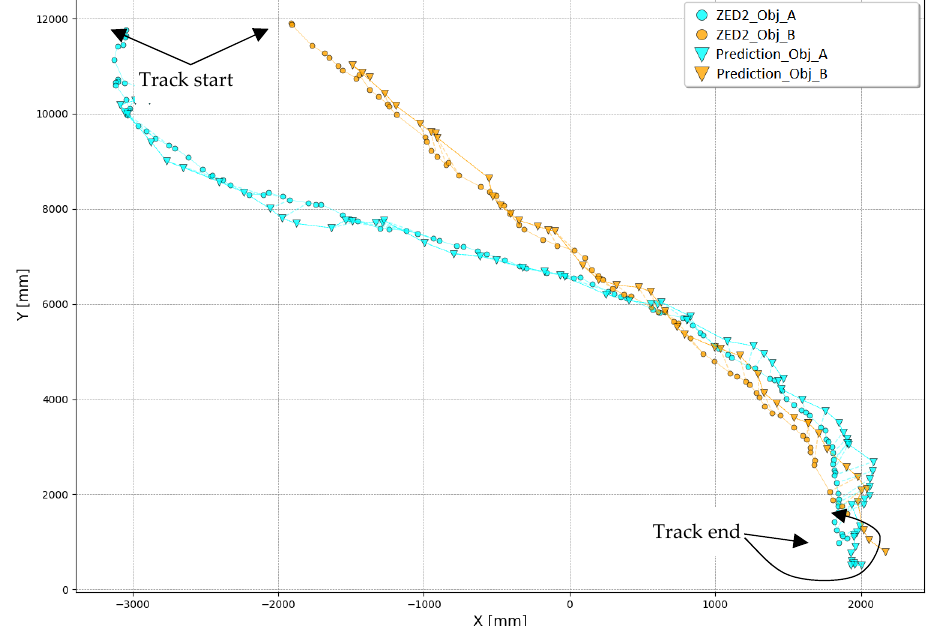
Figure 15. Two examples on raw 3D Video data and computed predictions.